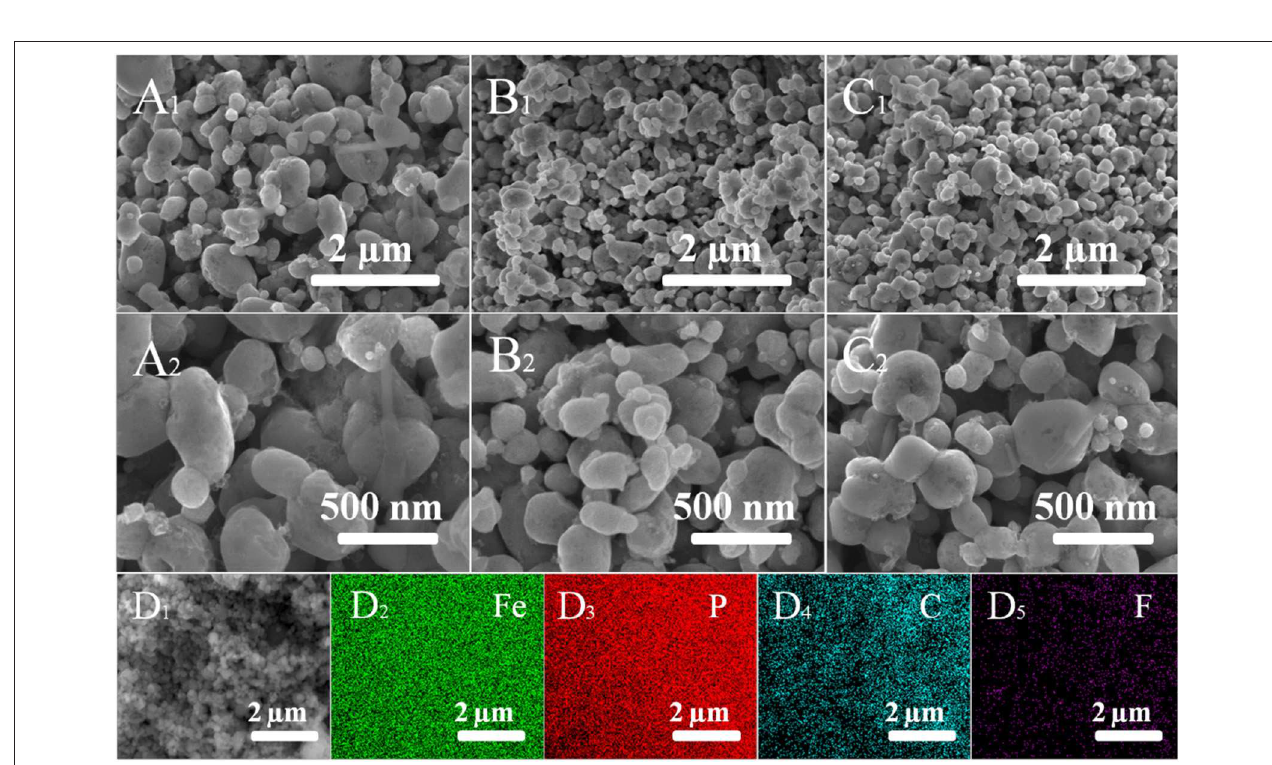
FIGURE 5 | SEM images of pure LFP (A 1 ,A 2 ) , LFP/C (B 1 ,B 2 ) , LFPF/CF (C 1 ,C 2 ) , and corresponding EDX elemental mapping images of Fe, P, C, and F (D 1 –D 4 ) .